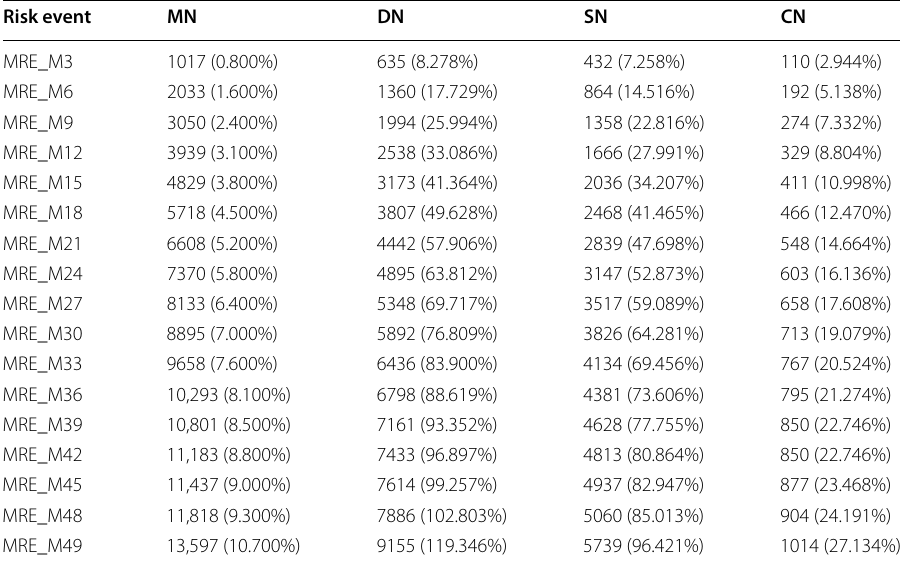
AP in different networks on NEEQ SMEs dataset +